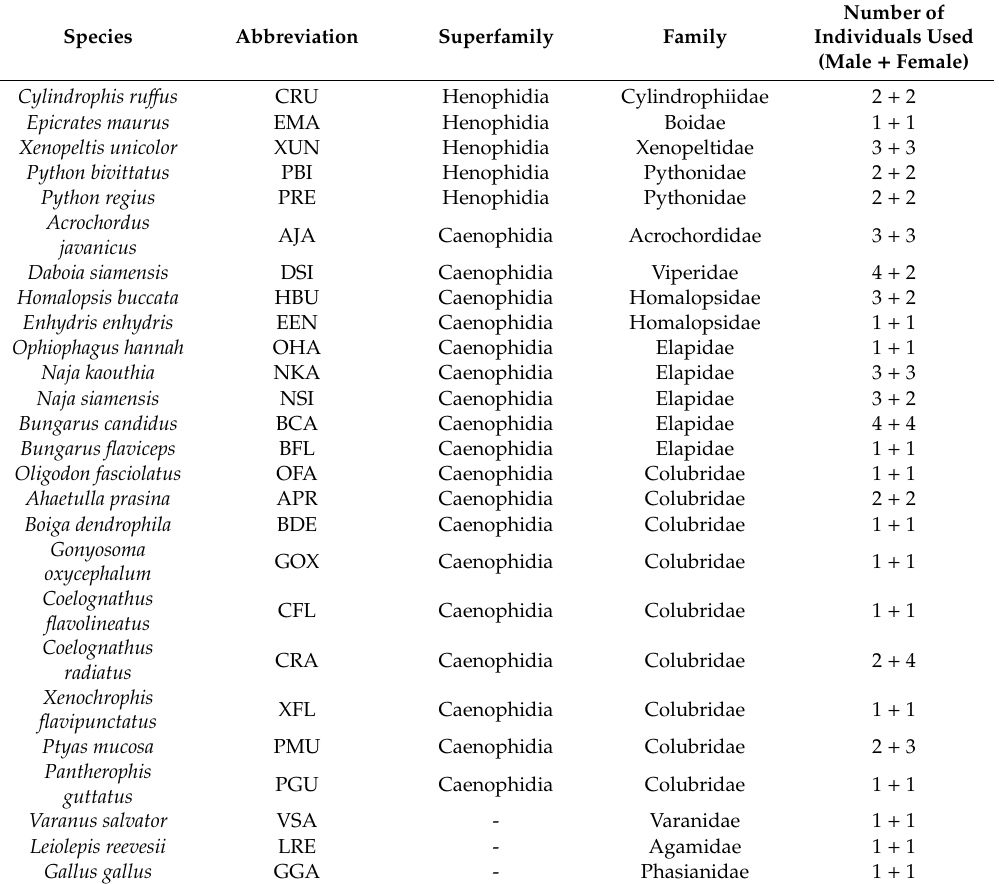
Table 1. Classification of species and numbers of samples used in this